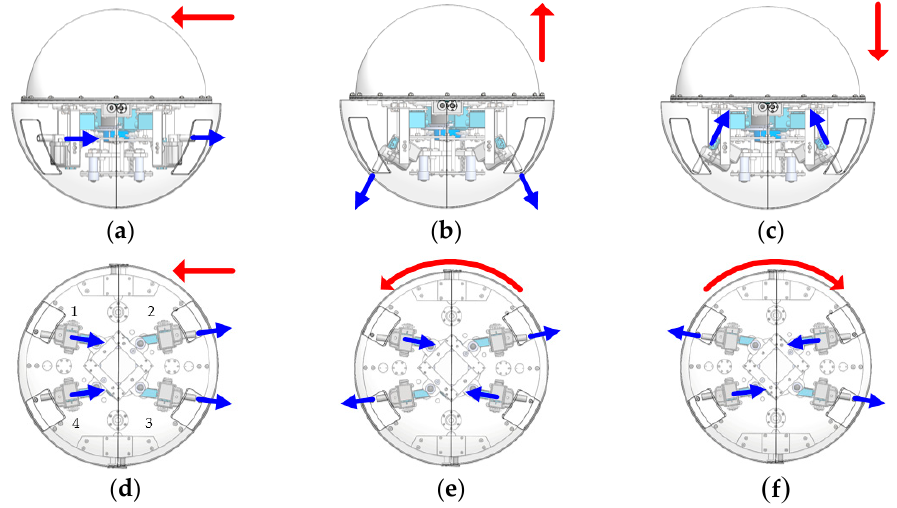
Figure 8. Underwater locomotion. Side view: ( a ) forward motion; ( b ) floating motion; ( c ) sinking motion. Bottom view: ( d ) forward motion; ( e ) left turning motion; ( f ) right turning motion. The blue arrow indicates the water-jet direction of the thruster, and the red arrow represents the motion direction of the robot.